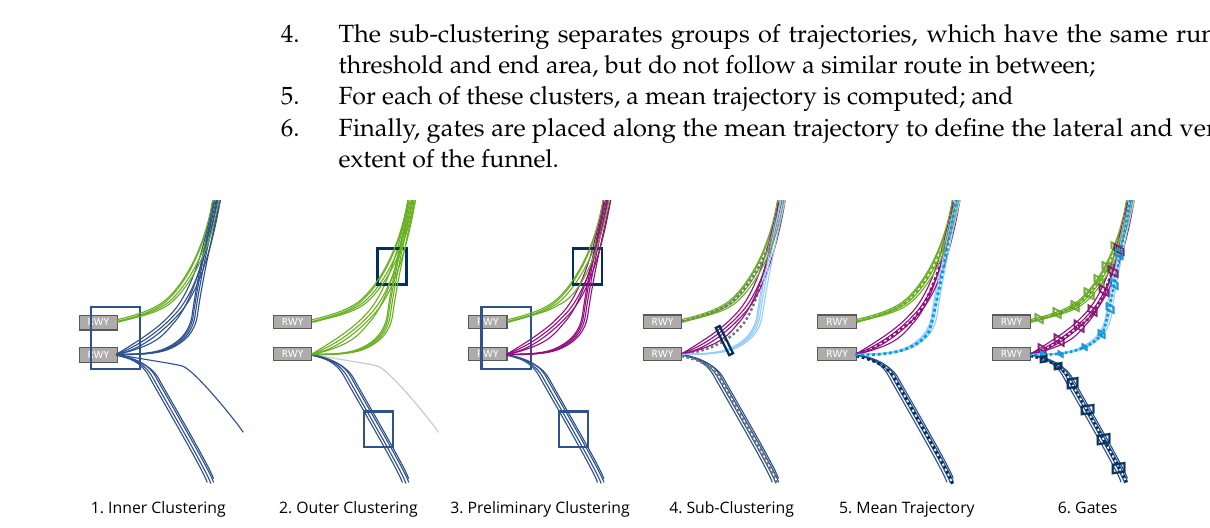
Figure 5. Computation steps for the traffic flow funnels, where the first four clustering steps group trajectories with a common runway threshold, end point at the E-TMA radius and similar routing in between, while the last two steps define the funnels based on a mean trajectory with gates for the lateral and vertical